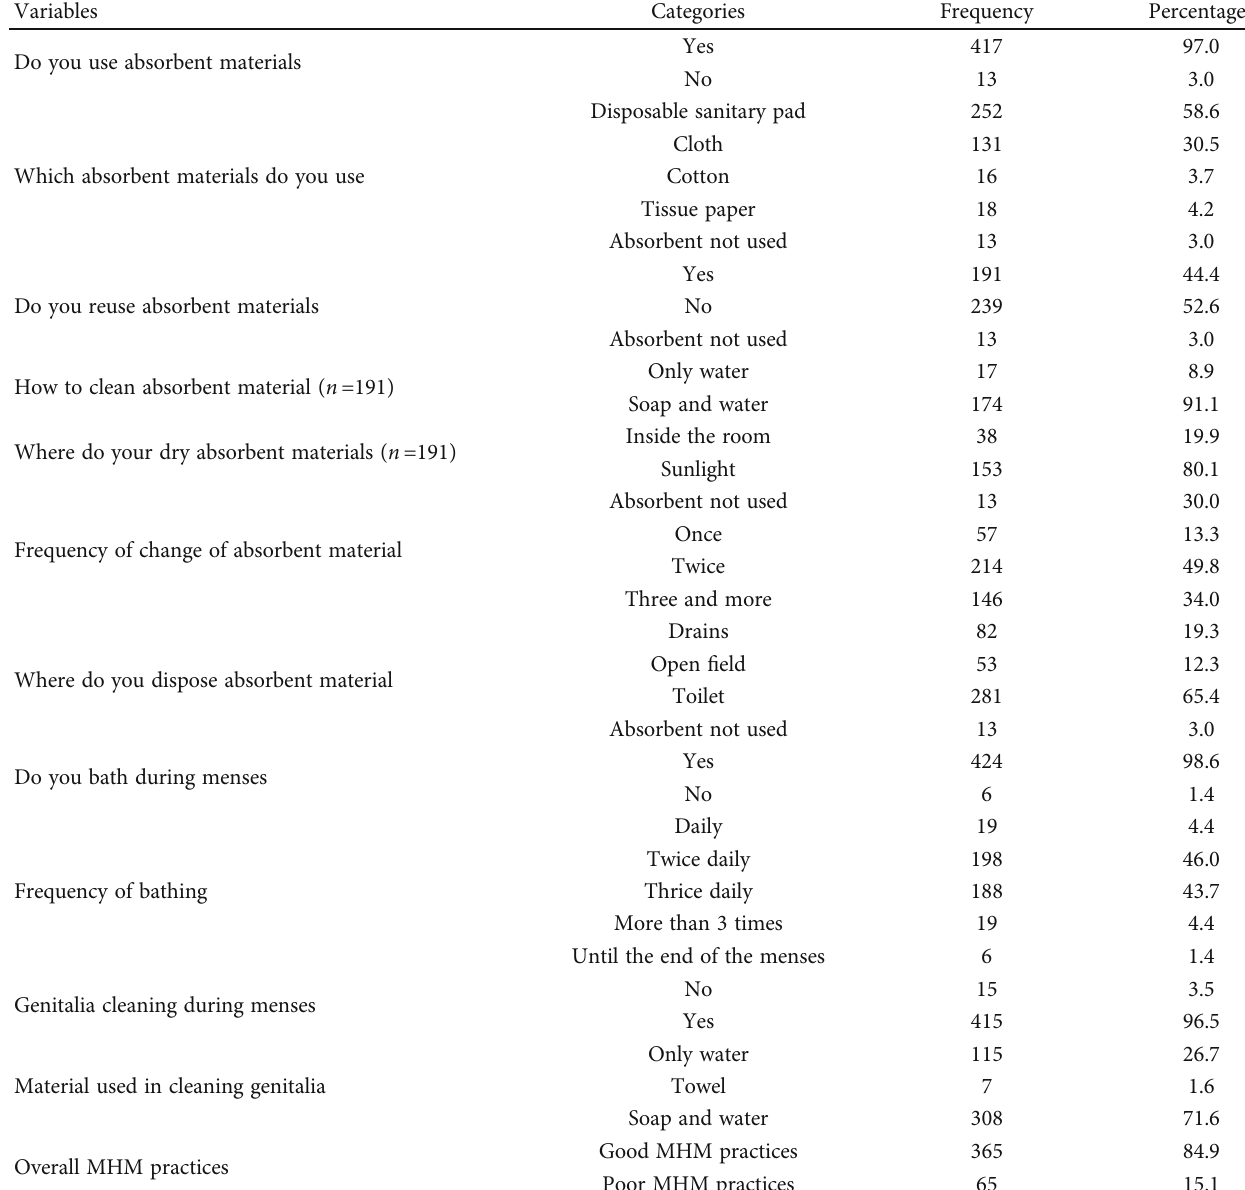
Table 2: Menstrual hygiene management practices among adolescent schoolgirls ( n